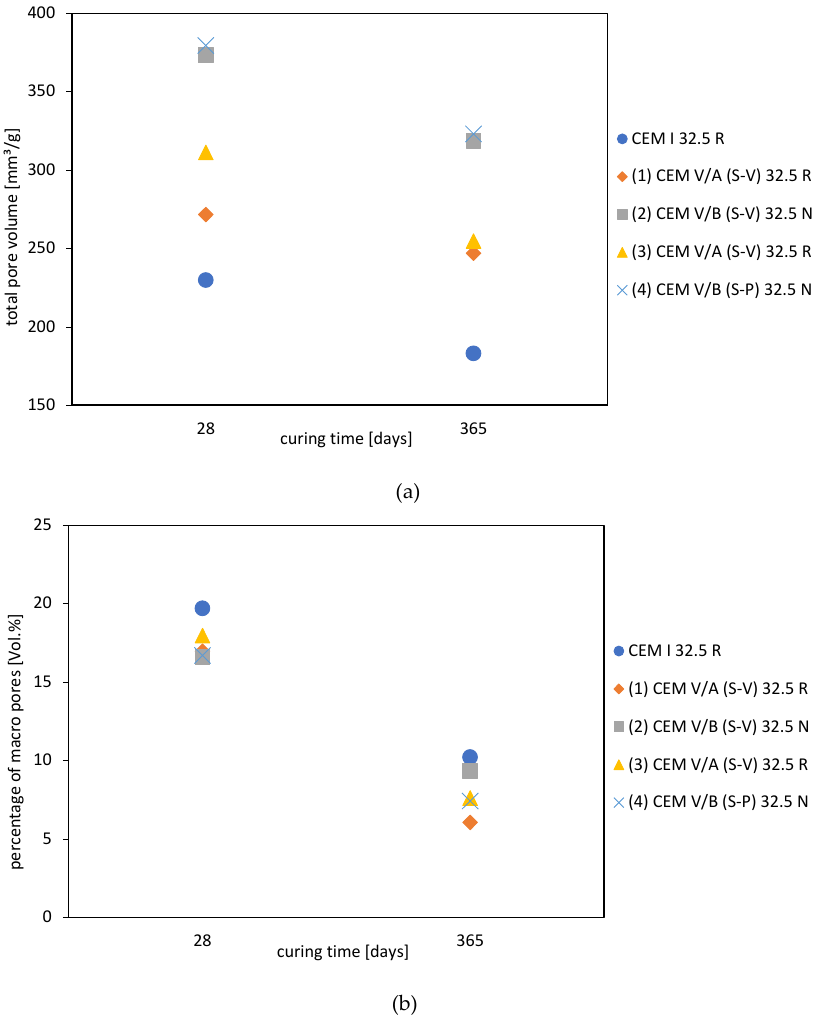
Figure 6. Development of total porosity ( a ) and percentage of macro-porosity ( b ) for a curing time of 28 and 365 days.